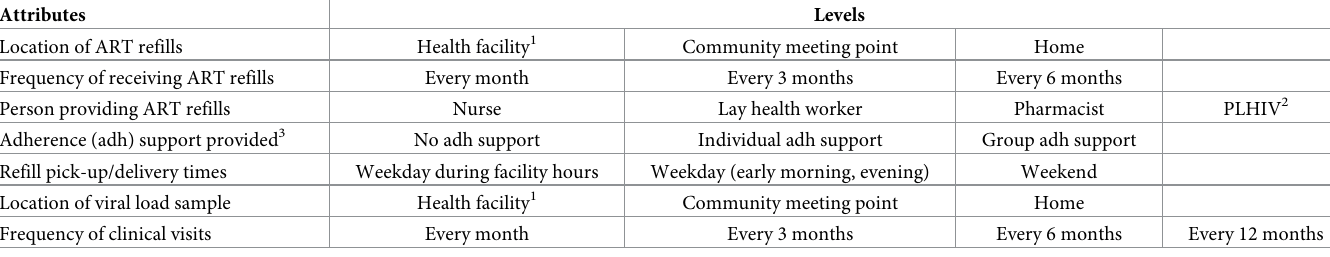
Table 1. Attributes and levels of differentiated care models for HIV in